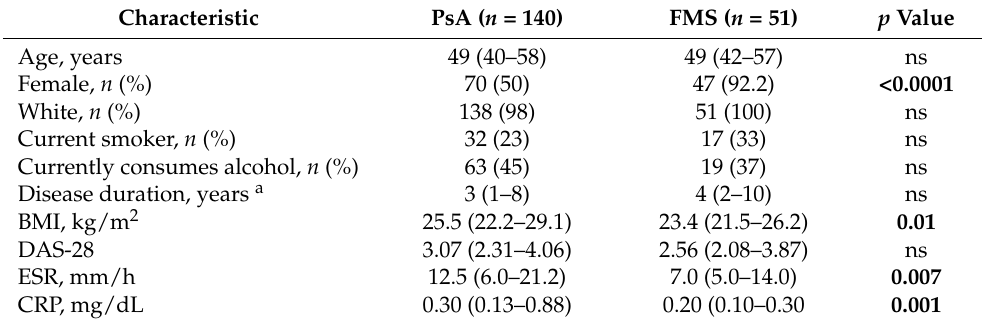
Table 1. Demographics and main clinical features of patients with PsA and those with FMS.